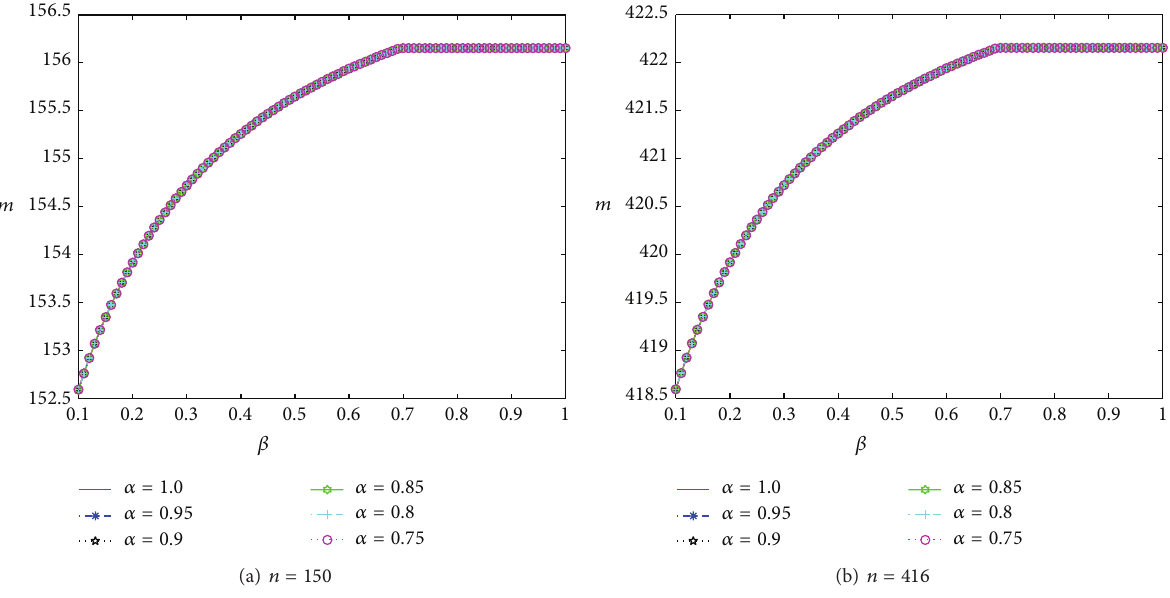
Figure 2: Optimal booking limit 𝑚 ∗ under the changes of 𝛼 and 𝛽 when 𝑏 = 8, 𝑗 = 8